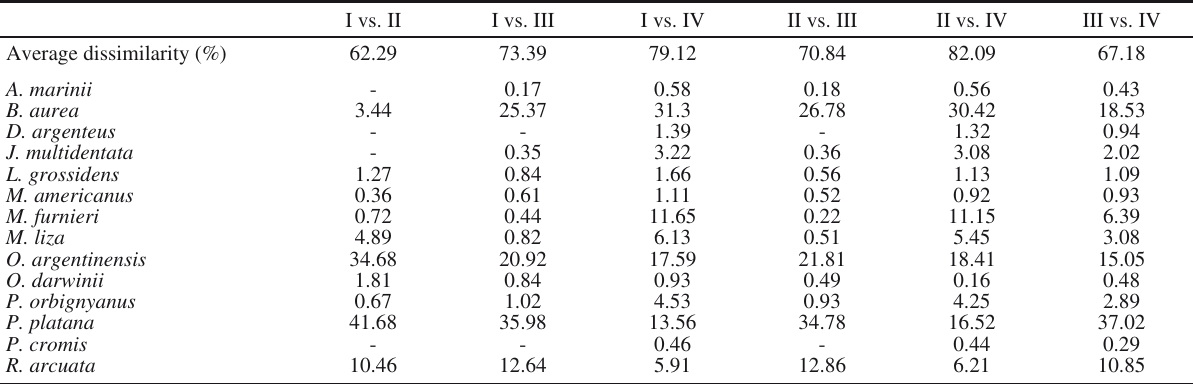
Table 3. – Species contribution (%) to the dissimilarity within groups defined by cluster analysis (CA) in the marine-estuarine gradient of Mar Chiquita lagoon. Groups: I, spring–estuary–Vivoratá; II, spring–early summer–surf zone; III, early summer–estuary–Vivoratá; IV, late